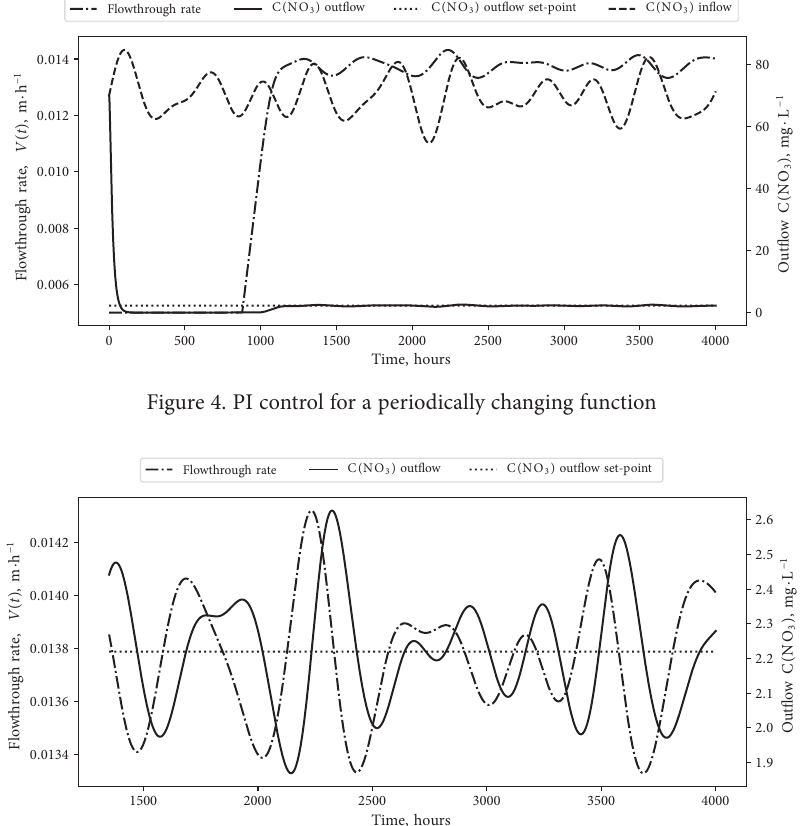
Figure 5. Time range from a Figure 4 where the process control is within the “flat”